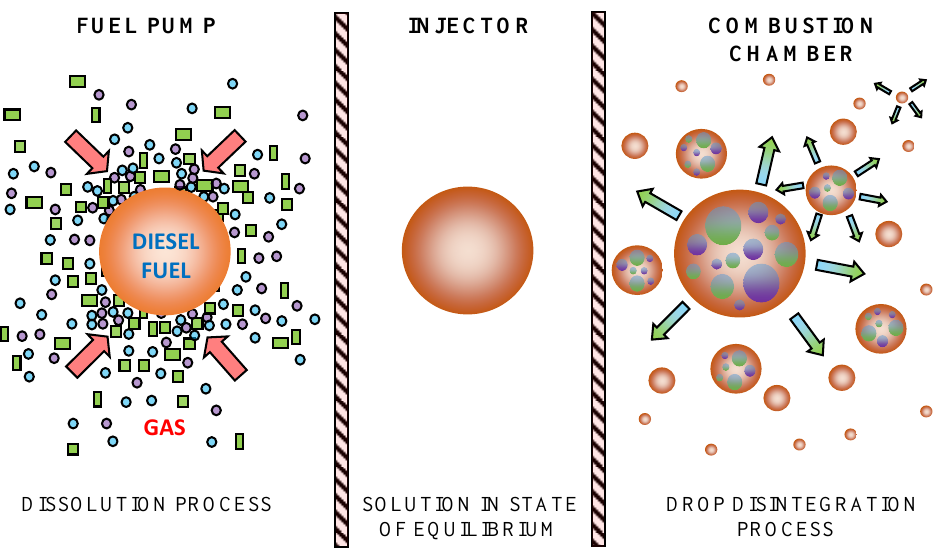
Figure 1. Illustration of the concept of spray support by gas dissolved in fuel.